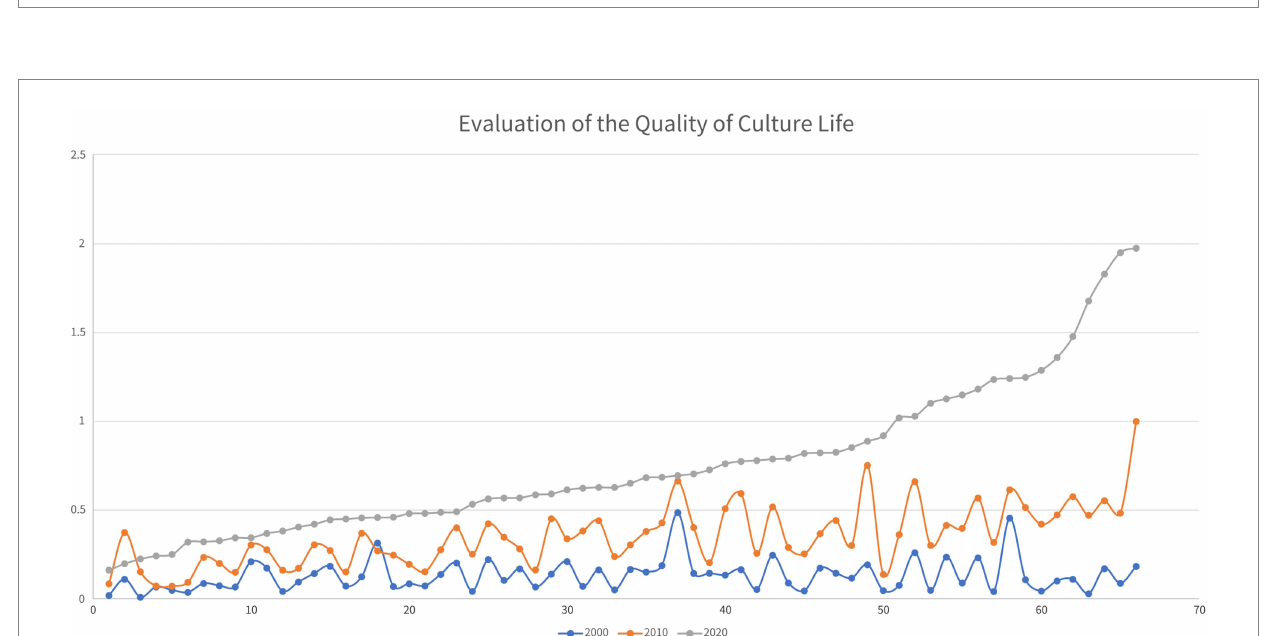
FIGURE 5 Analysis of the evolution of cultural QoL of Guizhou’s districts and counties from 2000 to 2020.